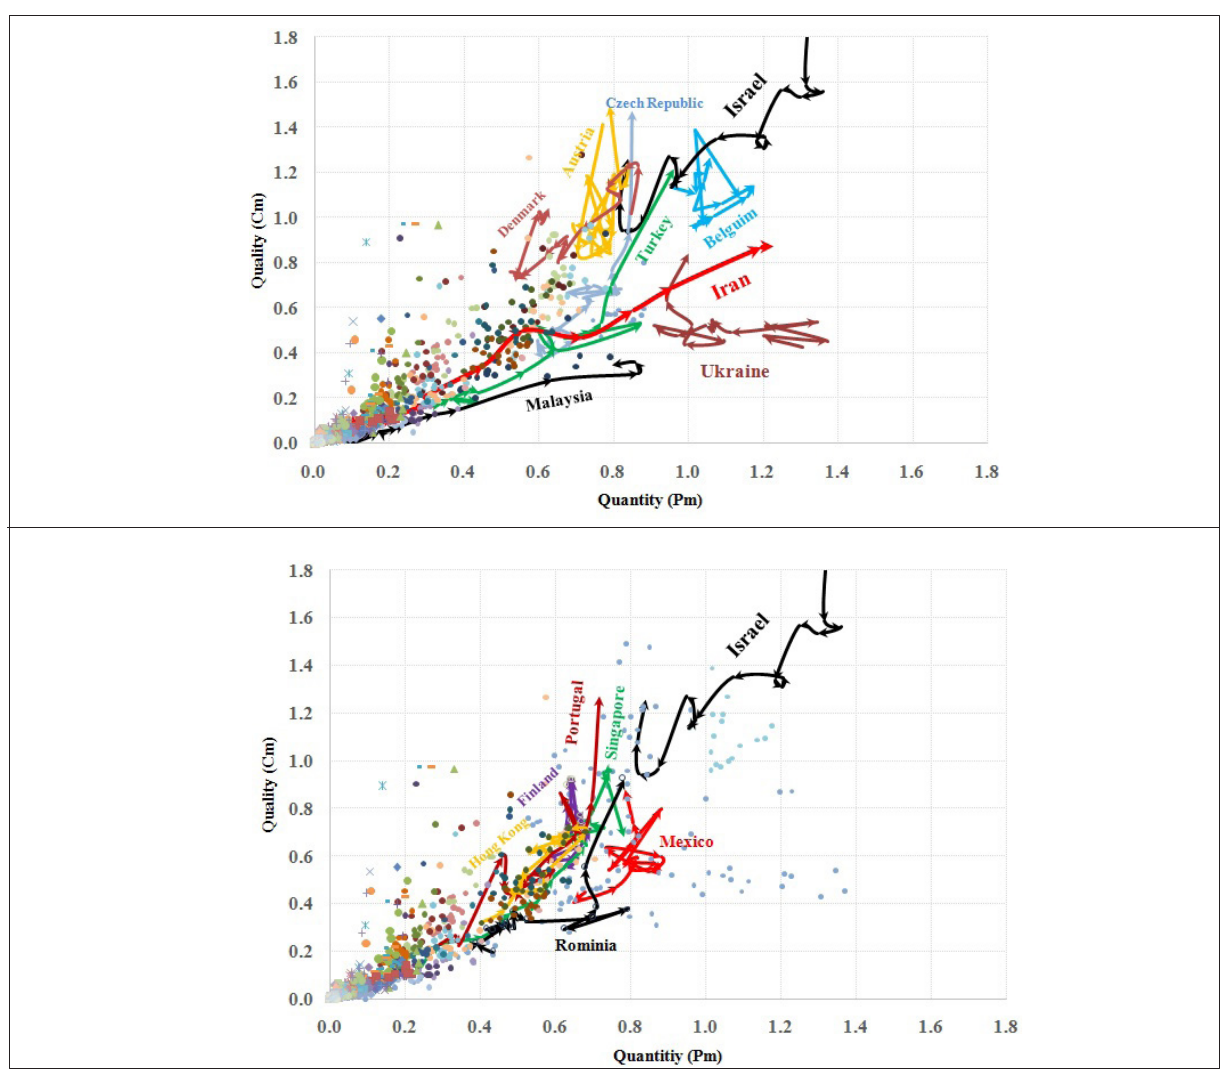
Figure 6: Countries with ‘average’ rank (shown in two pictures with the same scale).